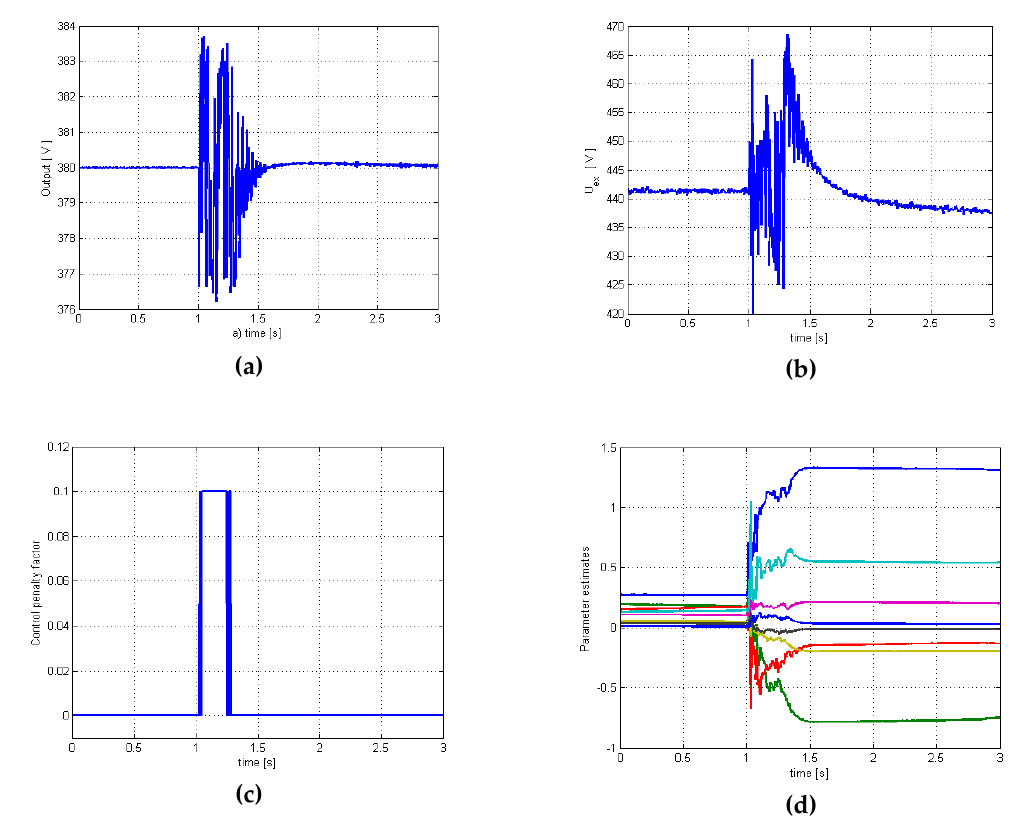
Figure 7. ( a ) Controlled output (terminal voltage)—electrical load ( ∆ R = 11%)— ρ ∈ { 0.0001, 0.1 } ; Figure 7. (a) Controlled output (terminal voltage)—electrical load ( (cid:1986)(cid:1844) = 11% ) — (cid:2025) ∈ {0.0001, 0.1} ; ( b ) Controller output (excitation voltage)—( ∆ R = 11%), ρ ∈ { 0.0001, 0.1 } ); ( c ) Variable setting of control (b) Controller output (excitation voltage)—( (cid:1986)(cid:1844) = 11% ), (cid:2025) ∈ {0.0001, 0.1} ); (c) Variable setting of penalty factor— ρ ∈ { 0.0001, 0.1 } ( ∆ R = 11%); ( d ) Parameter control penalty factor — (cid:2025) ∈ {0.0001, 0.1} ( (cid:1986)(cid:1844) = 11% ); (d) Parameter estimates